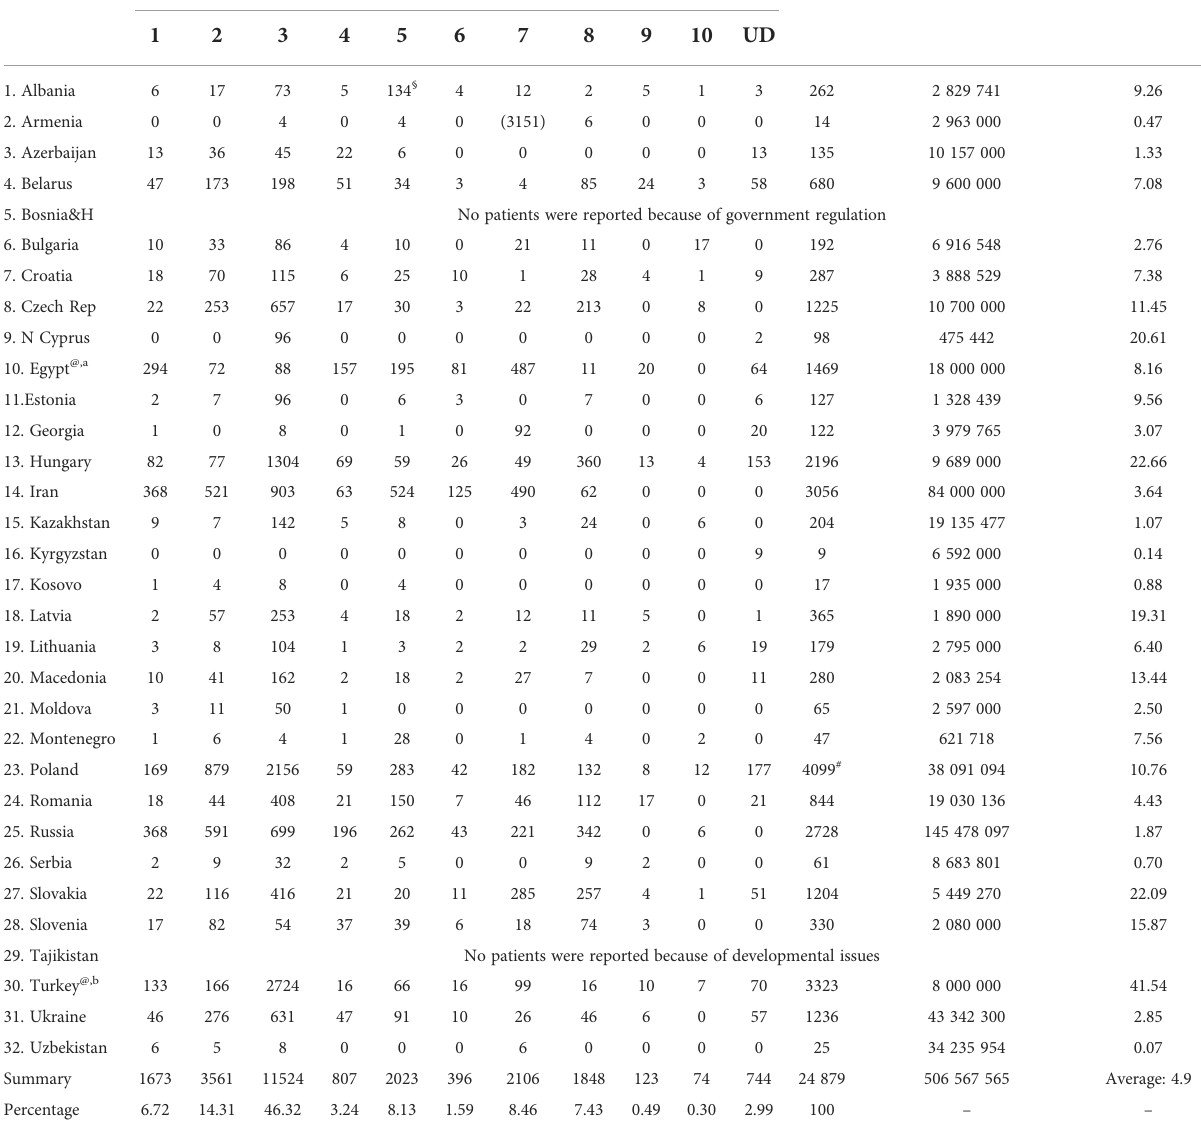
TABLE 1 Reported patients with inborn errors of immunity from J project countries/centers.